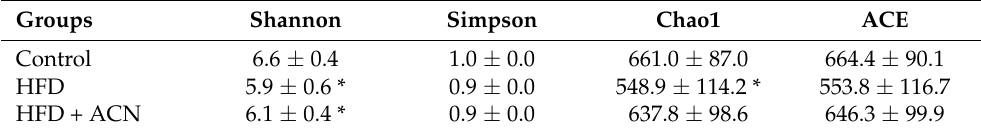
Table 2. The indexes of α -diversity. Data were expressed as the mean ± SD, n = 8. Groups